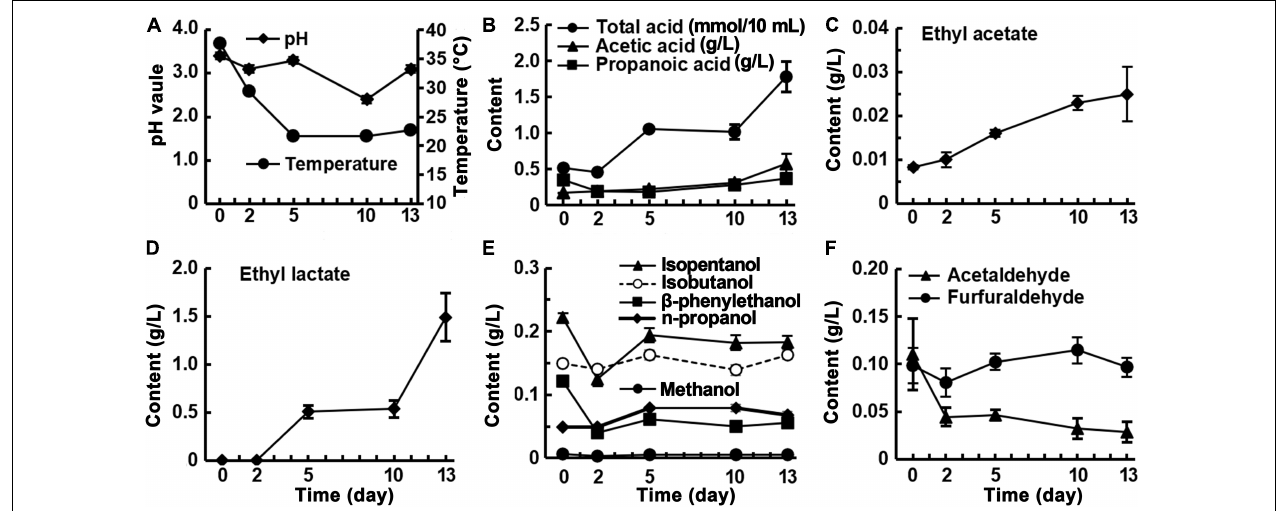
FIGURE 2 | Changes of physicochemical factors in fermented rice during the fermentation of rice-flavor baijiu.